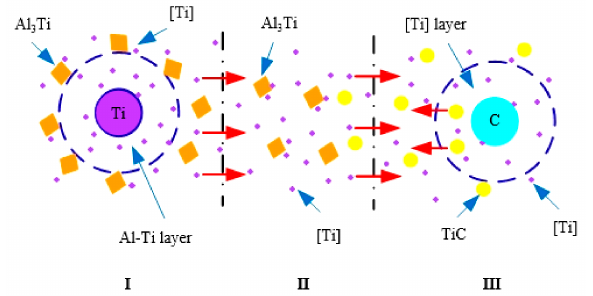
Figure 14. Microscopic kinetic model of TiC synthesis in the Al-5Ti-0.62C system. ( I ) 3Al(l) + Ti(s)